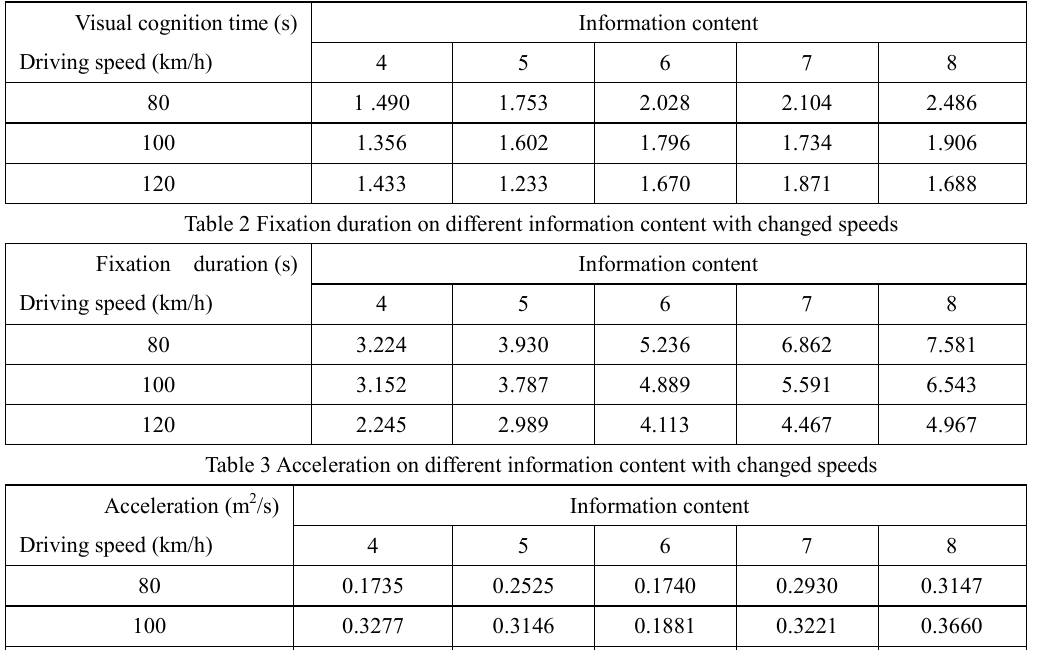
Table 1 Visual cognition time on different information content with changed speeds